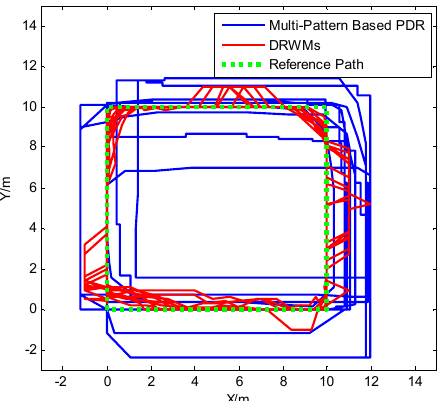
Figure 11. Comparison of multi-pattern-based pedestrian dead reckoning (PDR) and DRWMs.